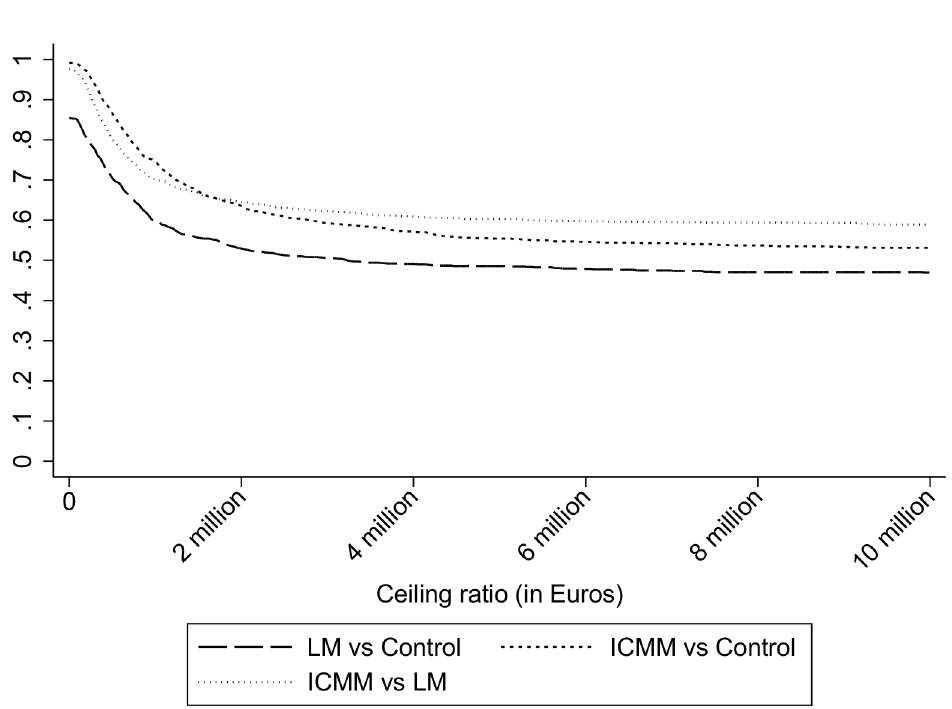
Fig 3. Cost-effectiveness curves. Cost-effectiveness curves for all pairwise comparisons for QALY of the person with dementia. The long dash represented the comparisons between LM versus control group. The short dash compared the cost-effectiveness of the ICMM versus Control group. Dots were used to represent the comparison of the ICMM compared to